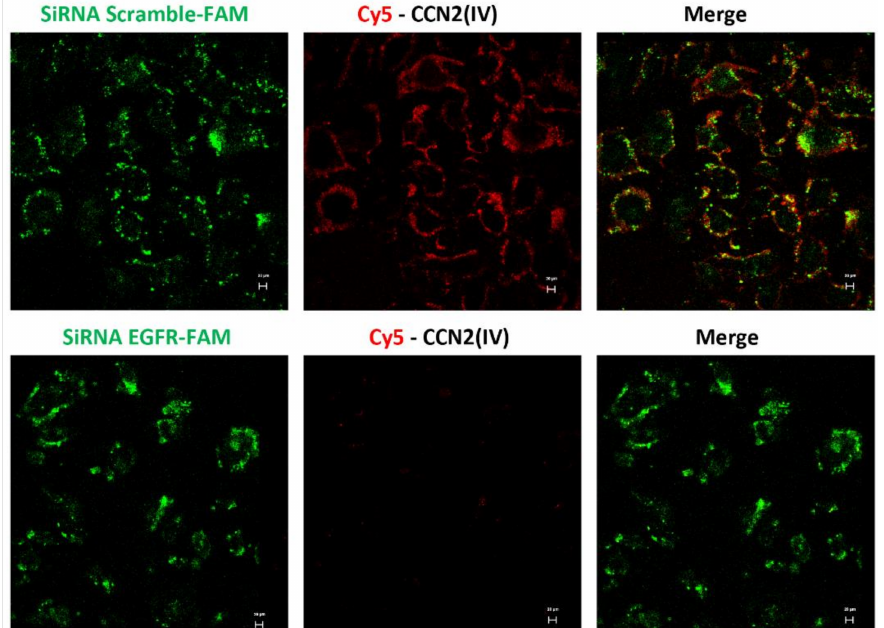
Figure 6. In vitro binding of Cy5-CCN2(IV) to tubular epithelial cells via EGFR. Serum-starved human tubular epithelial cells were transfected with a siRNA against EGFR or its corresponding scramble control siRNA, both FAM-labeled (green) and then stimulated with Cy5-CCN2(IV) for 10 min. Only cells expressing EGFR can bind to Cy5-CCN2(IV) (red signal), mainly located in the cellular membrane, whereas this signal is not found in EGFR-silenced cells. The scale bar represents 20 µ